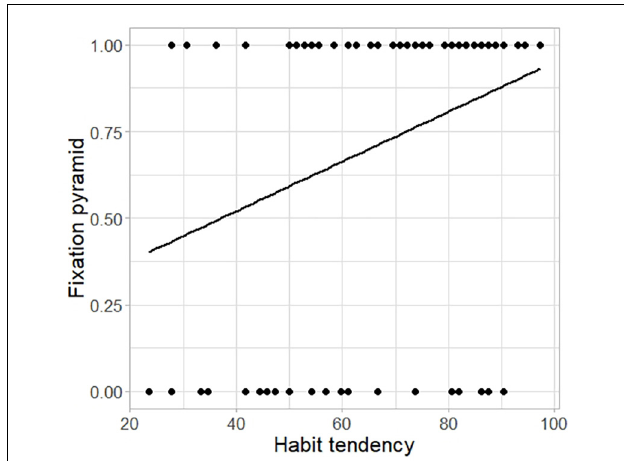
FIGURE 7 | Probability to overcome fixation in the pyramid puzzle as a function of habit tendency. Probability to overcome fixation (range: 0–1) in the pyramid puzzle as a function of habit tendency (measured by the SOAT; range: 0–100). Note that (1) a value of 1 on the y-axis indicates successfully overcoming fixation, as indicated in Table 1 , and (2) a high SOAT score indicates low